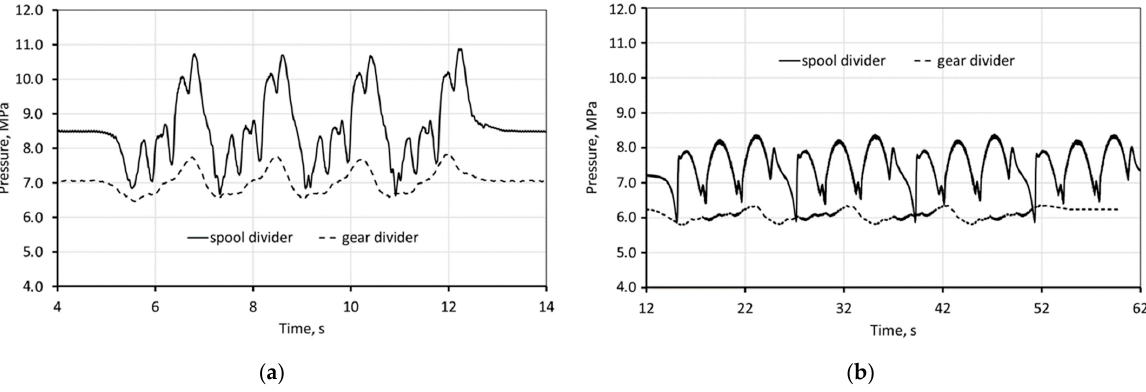
Figure 18. Pump pressure with nominal pump flow ( a ) and 25% of nominal pump flow ( b ) for spool and gear-type flow